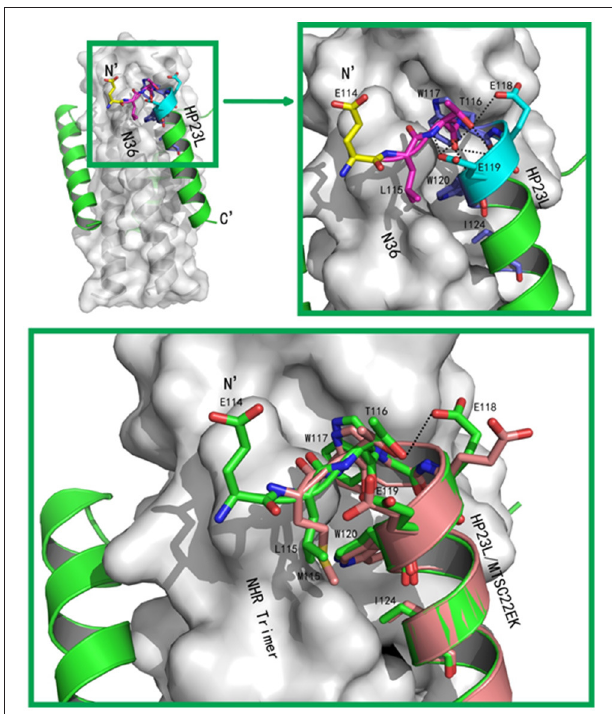
FIGURE 4 | Visualization of the L-T hook conformation of HP23L . (A) Crystal structure of HP23L/N36 is presented in ribbon and surface models. N36 trimer is in gray. Residues in the L-T hook region and pocket-binding domain are respectively colored in pink and blue in stick models. The extreme N-terminal glutamic is shown in yellow with labels, while other glutamic residues are shown as stick models in cyan with labels. Hydrogen bonds existed in L-T hook region are indicated in dashed lines. (B) The region of hydrophobic bond network of the L-T hook on HP23L is zoomed. The Hydrogen bonds in L-T hook region are indicated in dashed lines with respective distances. (C) The L-T hook of HP23L and the M-T hook of MT-SC22EK are superimposed for comparison. N36 and T21 trimers are shown as surface models in gray. HP23L and MT-SC22EK are shown as ribbon models and colored in green and salmon, respectively. The L-T hook region and pocket-binding domain are shown as stick models with labels. Hydrogen bonds existed in N-termini of HP23L are indicated in dashed black